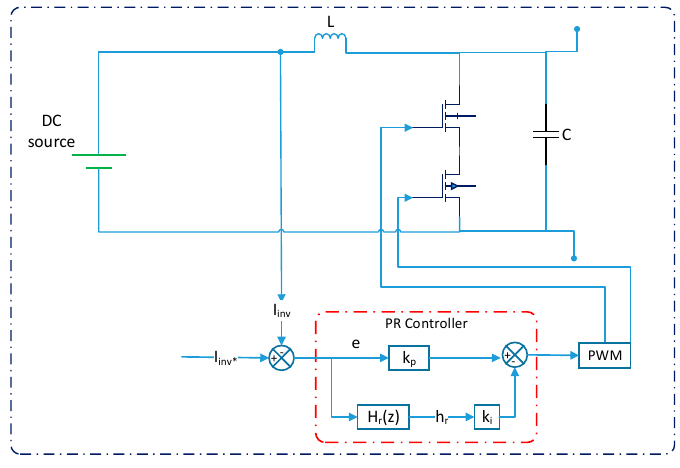
Figure 5. Proposed control block diagram.